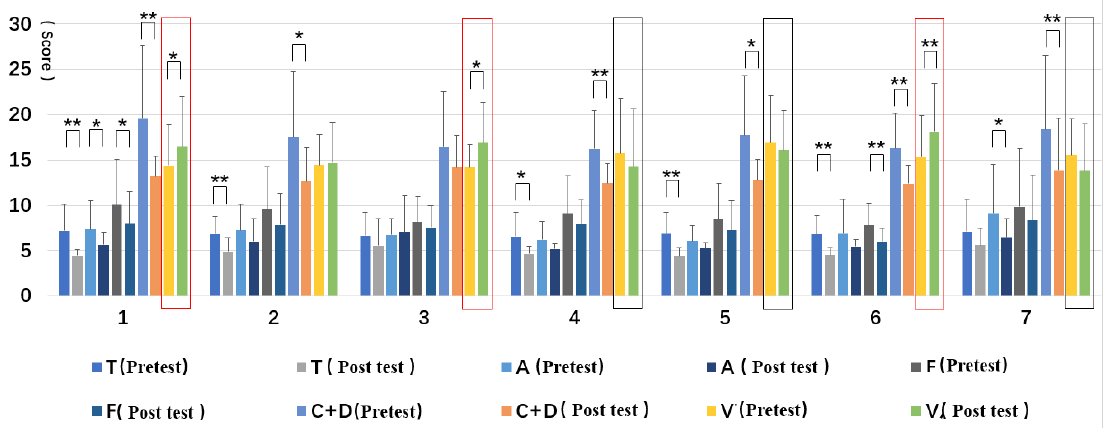
Figure 9. Pre- and post-test of each dimension of the BPOMS: ( 1 ) structure, ( 2 ) wood, ( 3 ) wood with bench, ( 4 ) wood with platform and bench, ( 5 ) platform with trees, ( 6 ) waterfall with trees, and ( 7 ) pool with plants. Interpretation: * means p < 0.05, ** means p < 0.01.